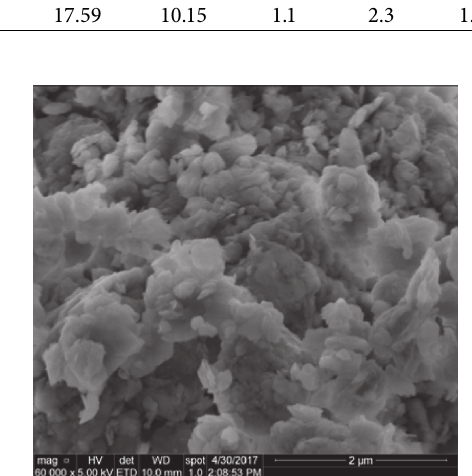
Figure 2: Scanning electron microscopic (SEM) image of Khulays natural bentonite.